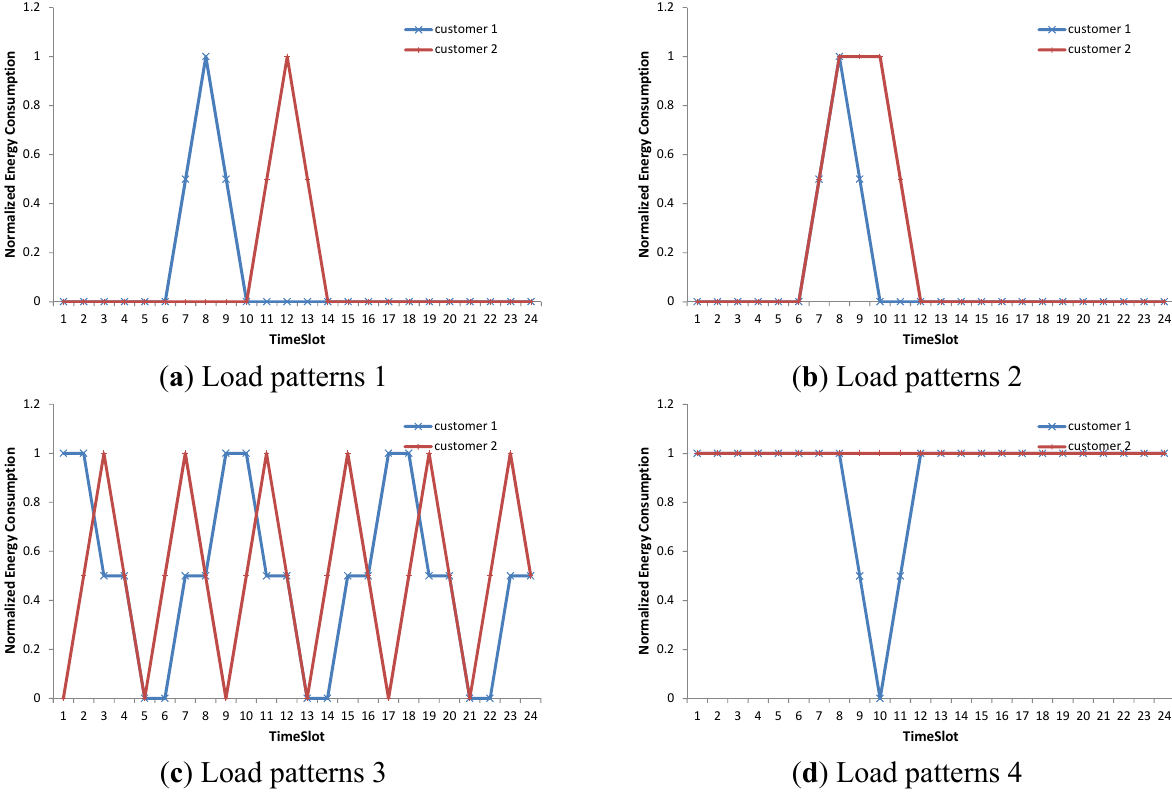
Figure 2. Representative samples for calculation of similarity. Two customers in ( a – c ) are considered as they are similar. Customers in ( d ) are not similar. ( a )–( d ) Load patterns